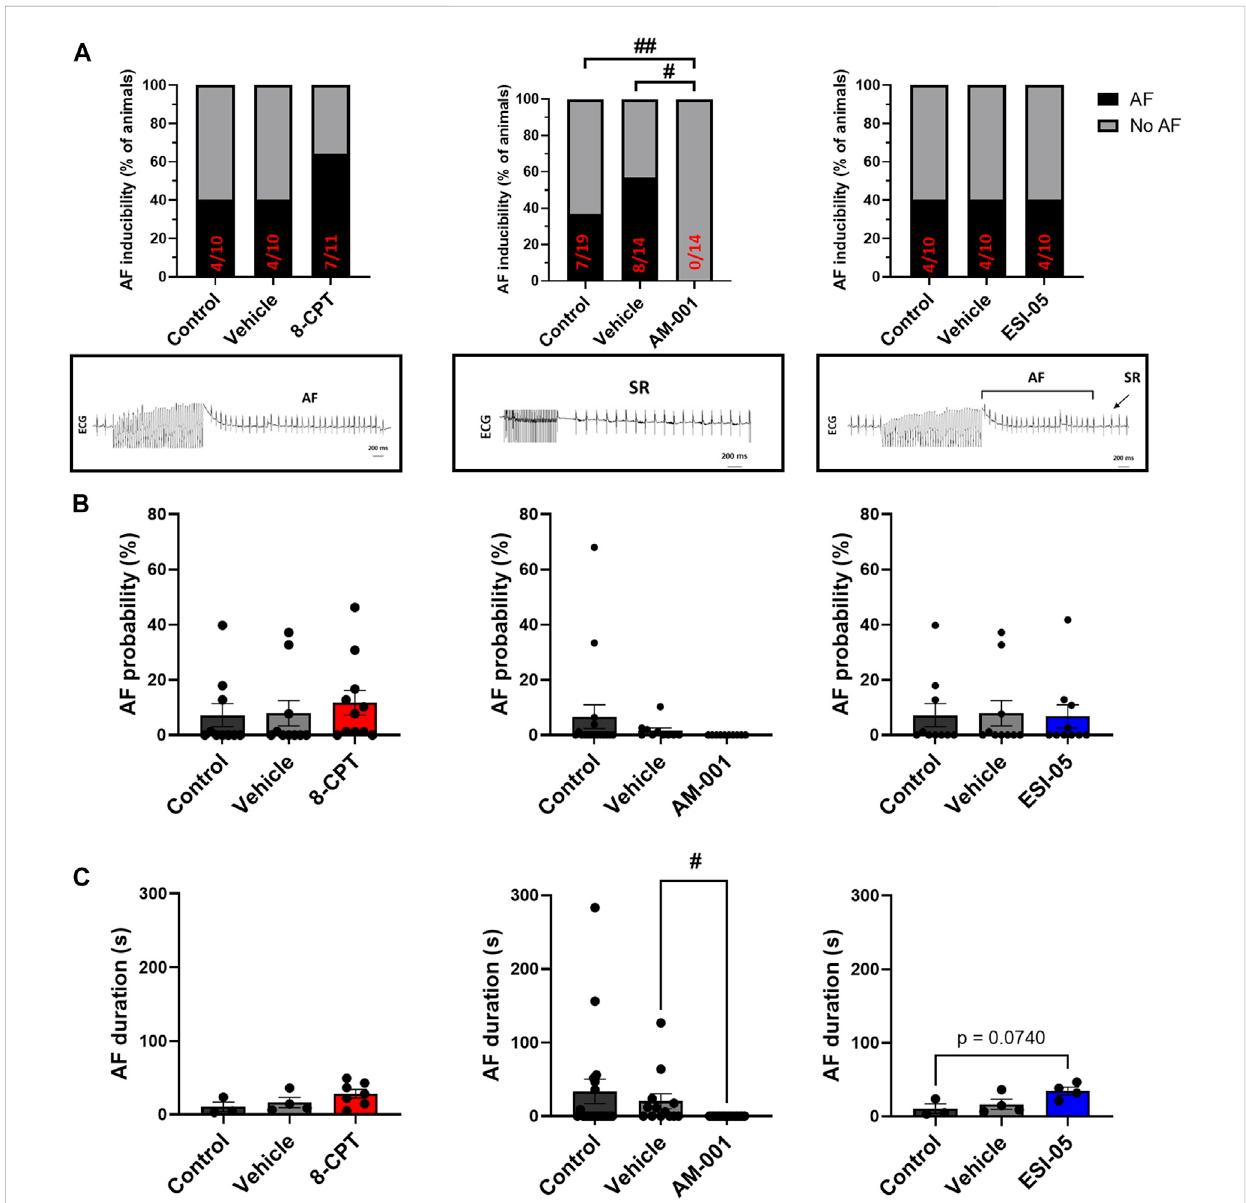
FIGURE 1 Invivo evaluationofAFinducibility,probabilityanddurationbymodulationofEPACactivityinWTmice. (A)